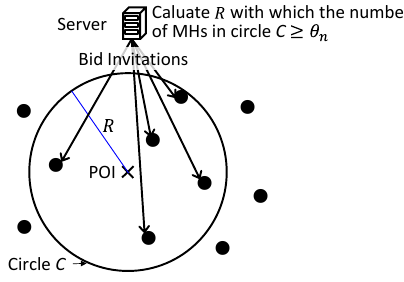
Figure 4. How to select mobile hosts that can obtain data for a data request (existing method, for 𝜃 𝑛 = 5 ).